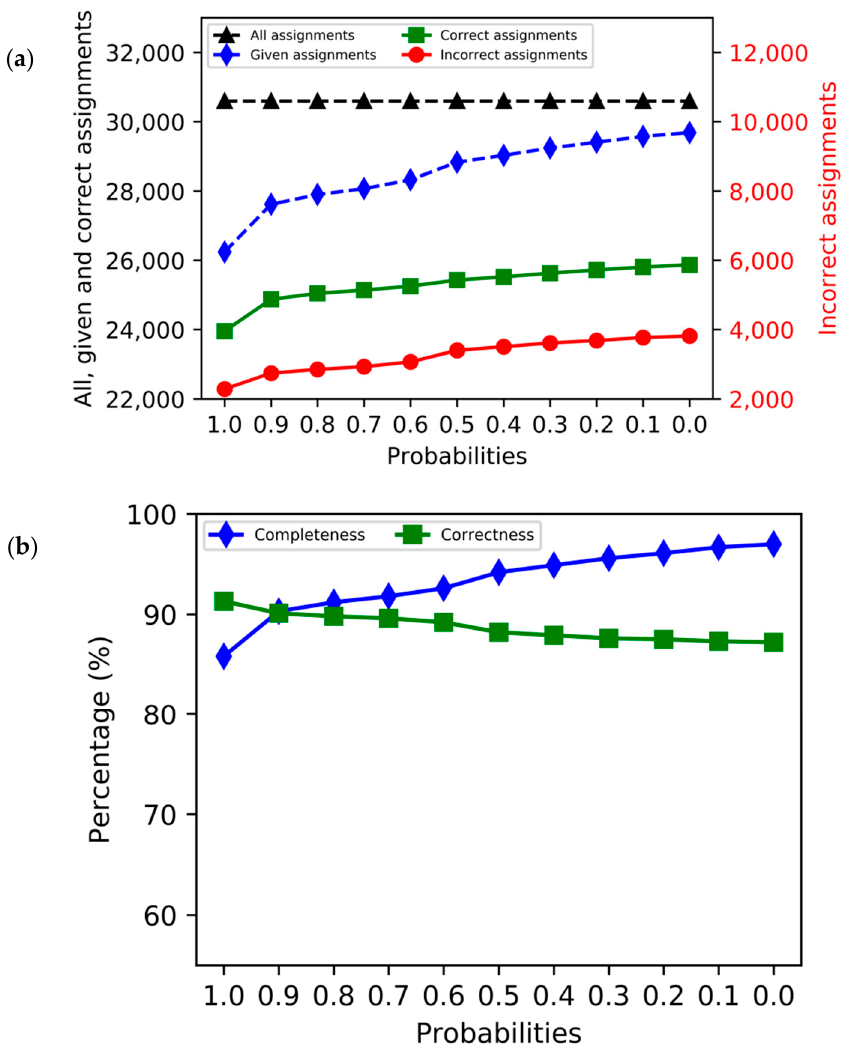
Figure 3. Results from ssPINE analysis of synthetic ssNMR data as averages for the 82 proteins studied. ( a ) Chemical shift assignment probabilities returned by ssPINE for all assignment candidates (x-axis) versus assignment type (y-axis). All (dashed black), given (dashed blue), and correct (solid green) assignments are represented by the numbers on the left side, whereas the incorrect assignments (solid red) are represented by the numbers on the right side. ( b ) Data from the assignment candidate for each protein with the highest assignment probability. Completeness (solid blue) and correctness (solid green) are plotted as a function of that assignment probability.